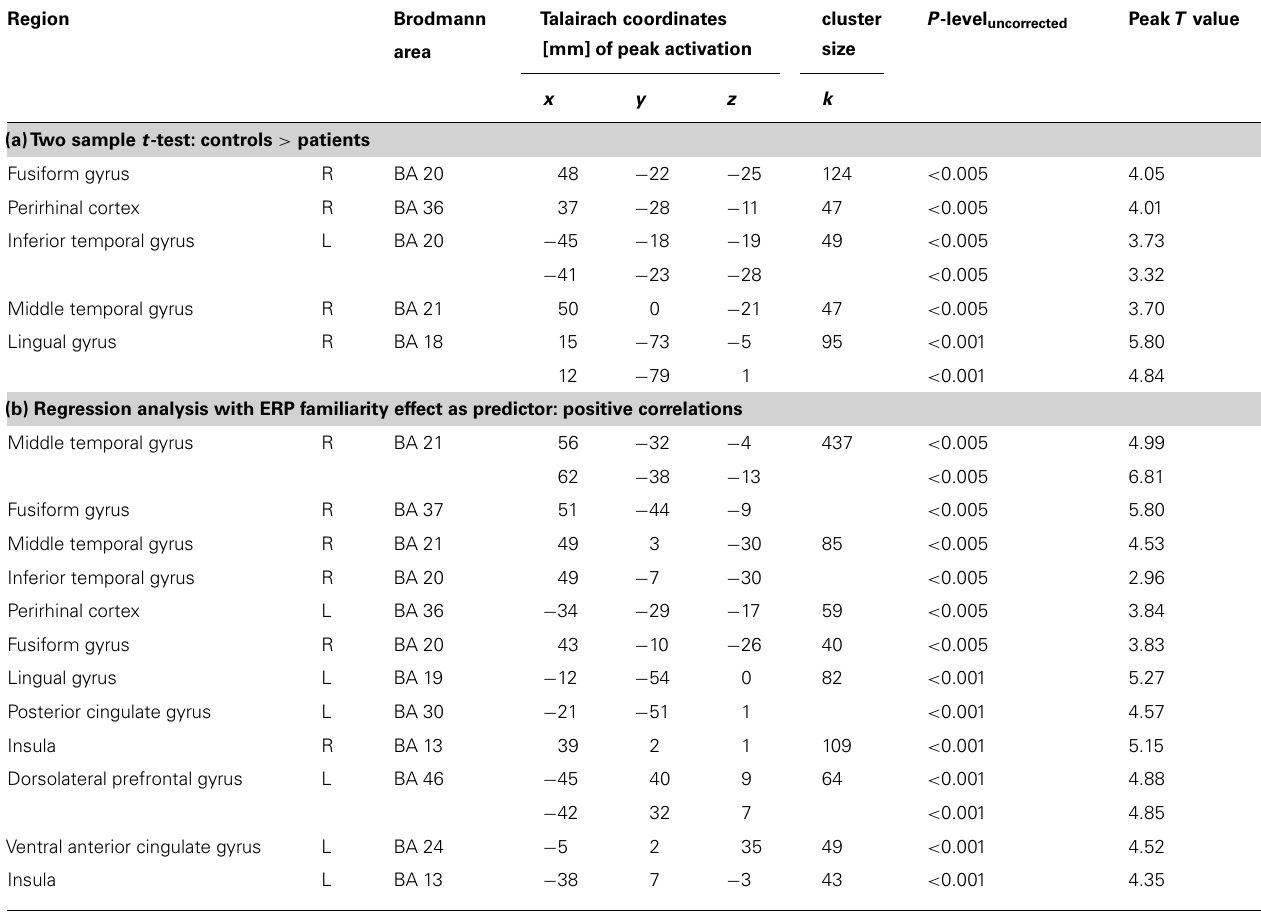
Table 4 | (a) Regional gray matter differences between controls and patients and (b) regions where gray matter volume positively correlates with the magnitude of the frontal old/new effect. Region Brodmann Talairach coordinates cluster P -level uncorrected Peak T value [mm] of peak activation size area x y z k (a)Two sample t -test: controls > patients Fusiform gyrus R BA 20 48 − 22 − 25 124 < 0.005 4.05 Perirhinal cortex R BA 36 37 − 28 − 11 47 < 0.005 4.01 Inferior temporal gyrus L BA 20 − 45 − 18 − 19 49 < 0.005 3.73 − 41 − 23 − 28 < 0.005 3.32 Middle temporal gyrus R BA 21 50 0 − 21 47 < 0.005 3.70 Lingual gyrus R BA 18 15 − 73 − 5 95 < 0.001 < 0.001 4.84